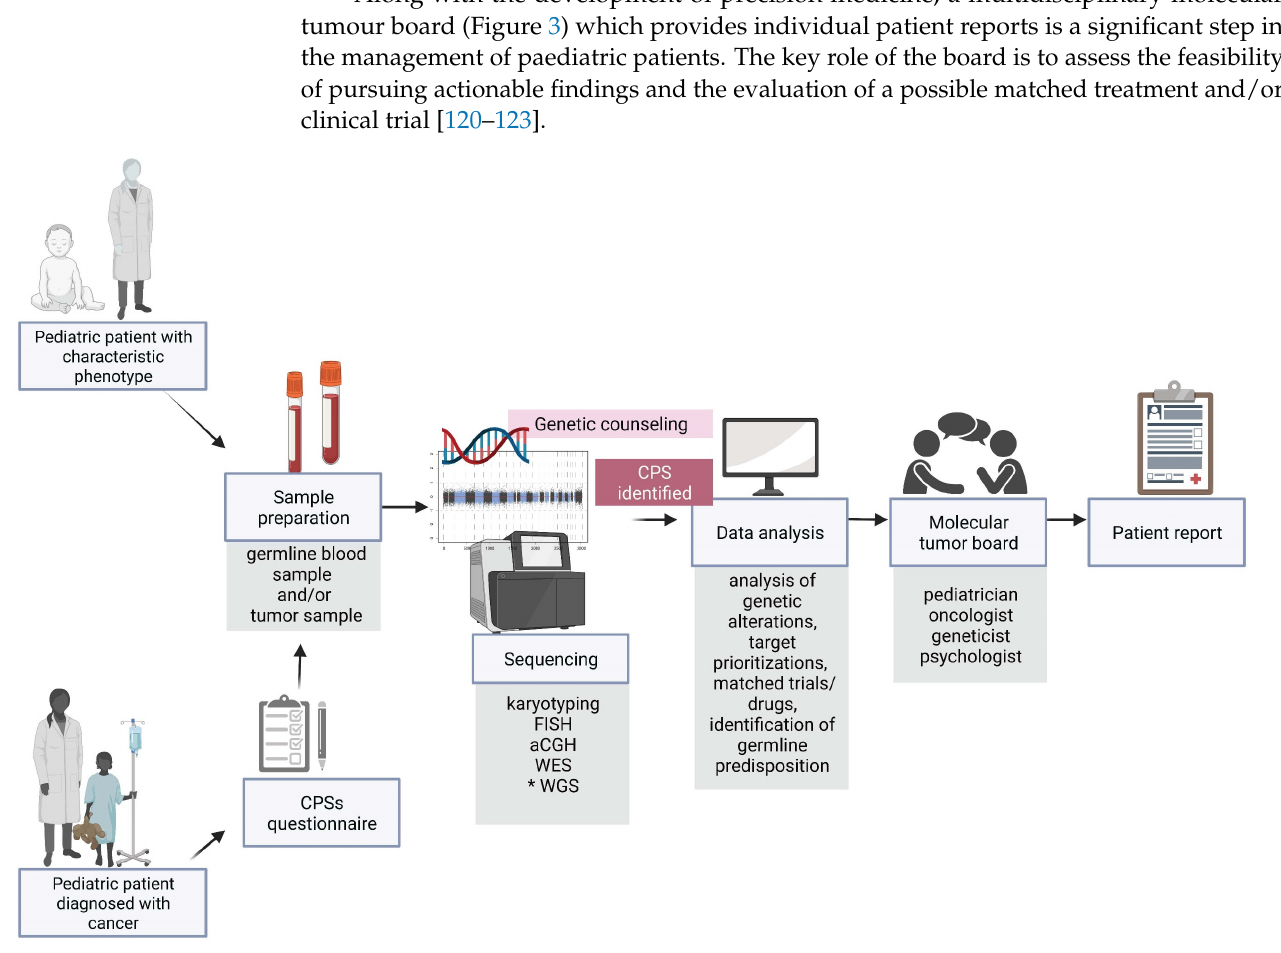
Figure 3. Overview of diagnostic and therapeutic approaches, highlighting a great importance of the early diagnosis of germline predisposition to paediatric neoplasms. CPS—cancer predisposition syndrome, FISH—fluorescence in situ hybridization, aCGH—array comparative genomic hybridization, WES—whole exome sequencing, WGS—whole genome sequencing. * the genetic examination not performed routinely. Image created with BioRender.com, accessed on 13 April 2022.